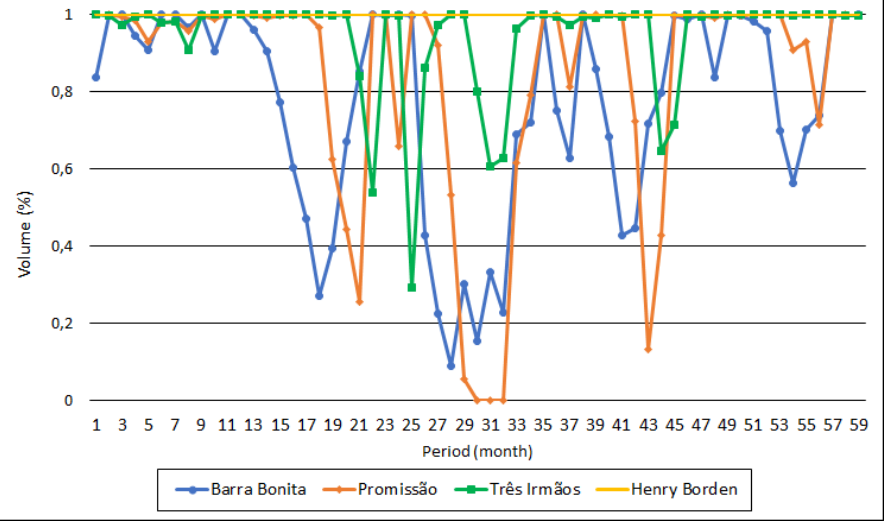
Figure 10. Volume trajectory of plants for case study 02 (2013-2018) with water